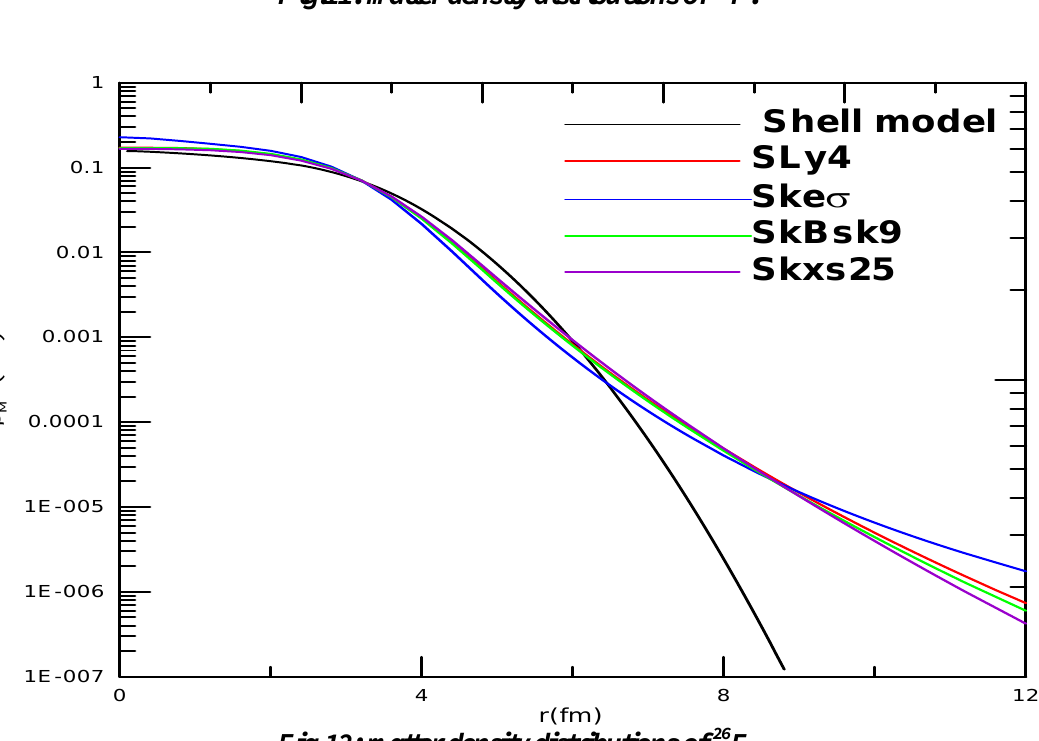
Fig.11: matter density distributions of 25 F.